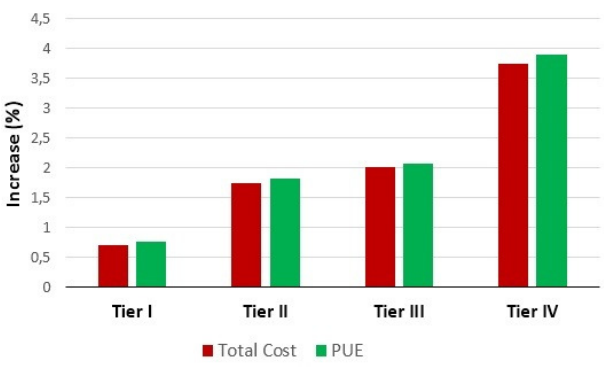
Figure 22. Comparison before and after PLDA-D execution.